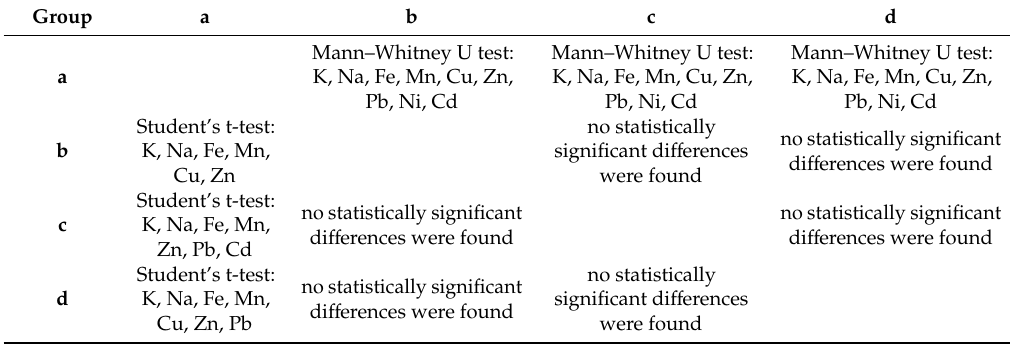
Table 6. Summary of the results of the analysis of di ff erences in composition between the tested sample groups (a—new samples, b—composted samples without irradiation, c—composted samples irradiated for 20 h, d—composted samples irradiated for 50 h)—the contents of the mentioned metals in the groups di ff ered